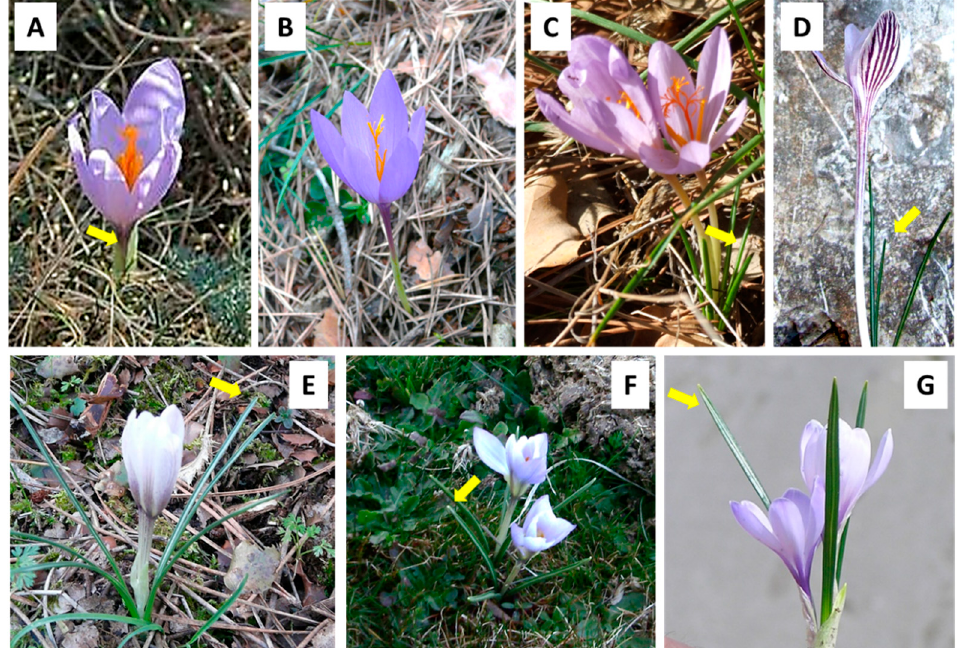
Figure 2. Leaf development (arrows) in flowering time of autumn-flowering C. serotinus ( A ); C. nudiflorus ( B ); C. clusii ( C ); C. cambessedesii ( D ) and spring-flowering C. nevadensis ( E ); C. carpetanus ( F ); C. vernus ( G ).